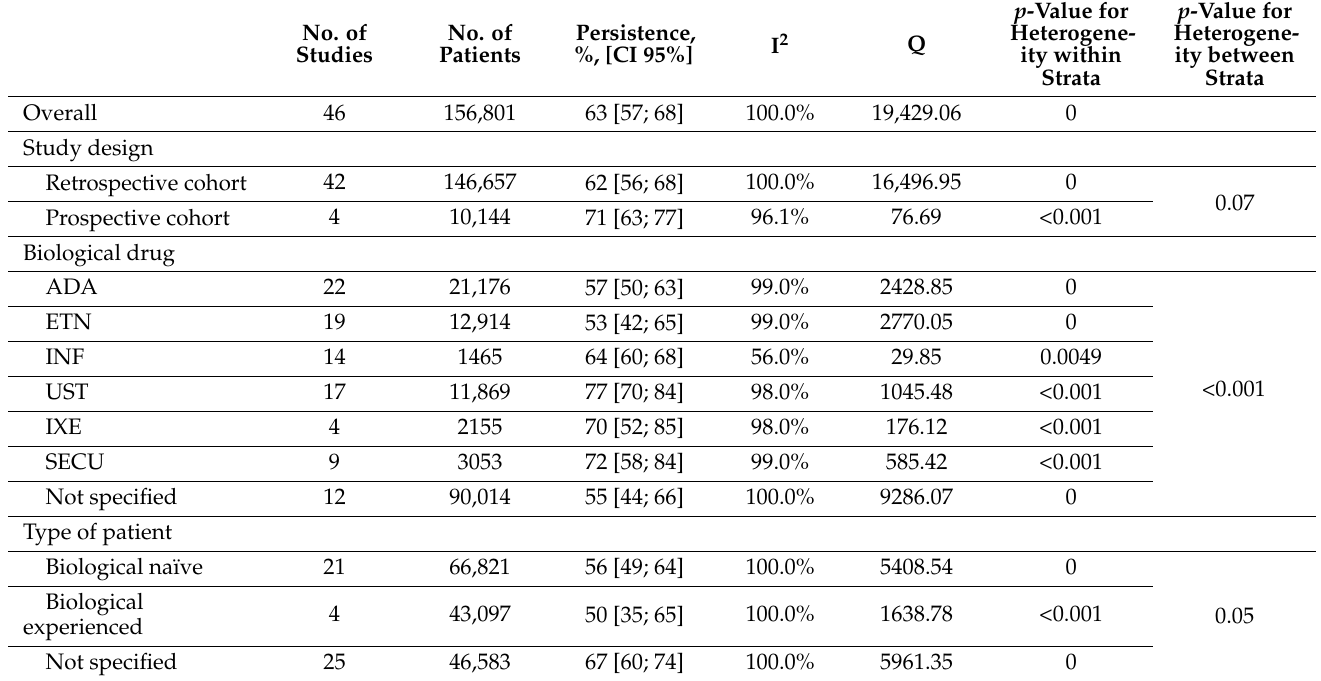
Table 3. Pooled proportions of persistent patients stratified according to study design, type of biological drug, and type of